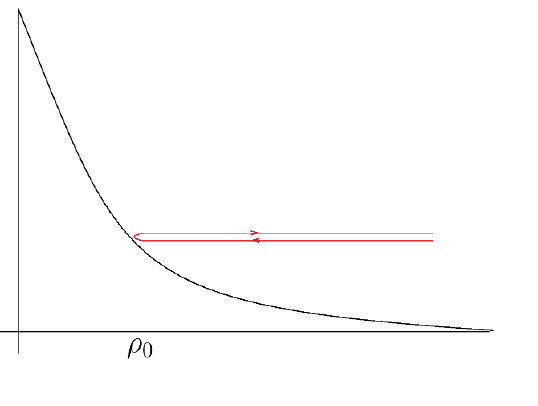
Figure 1 . The e(cid:11)ective